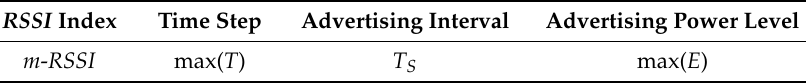
Table 4. Optimal parameters for the proposed localization approach.